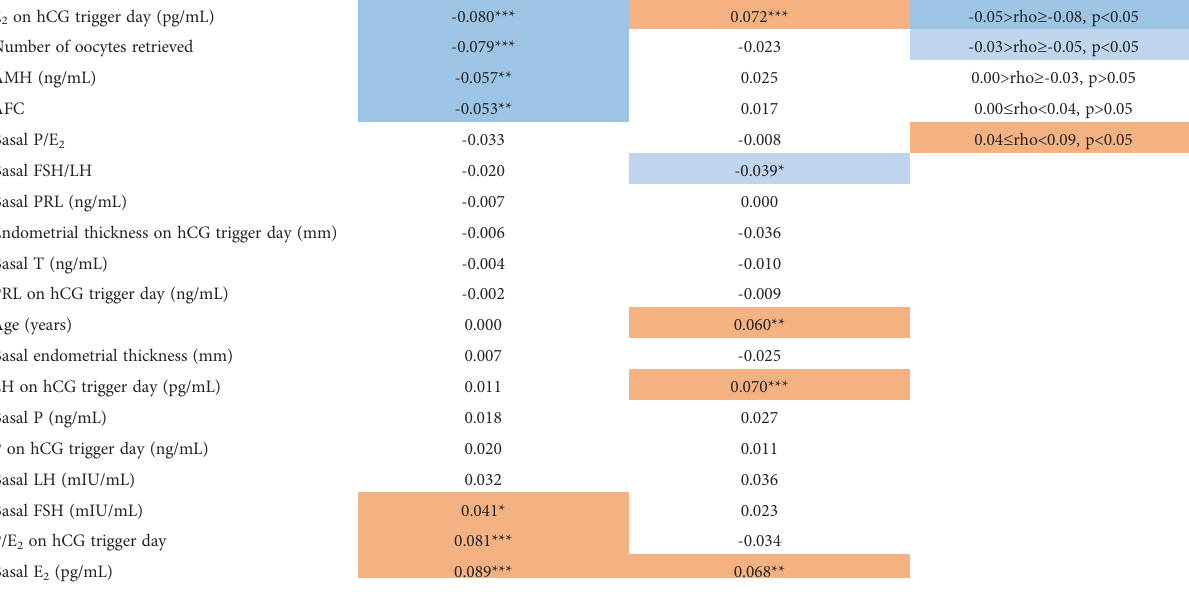
TABLE 2 Analysis and comparison of the correlation between free and total 25(OH)VitD with fertility parameters and COH outcomes in IVF-ET females. Parameter,